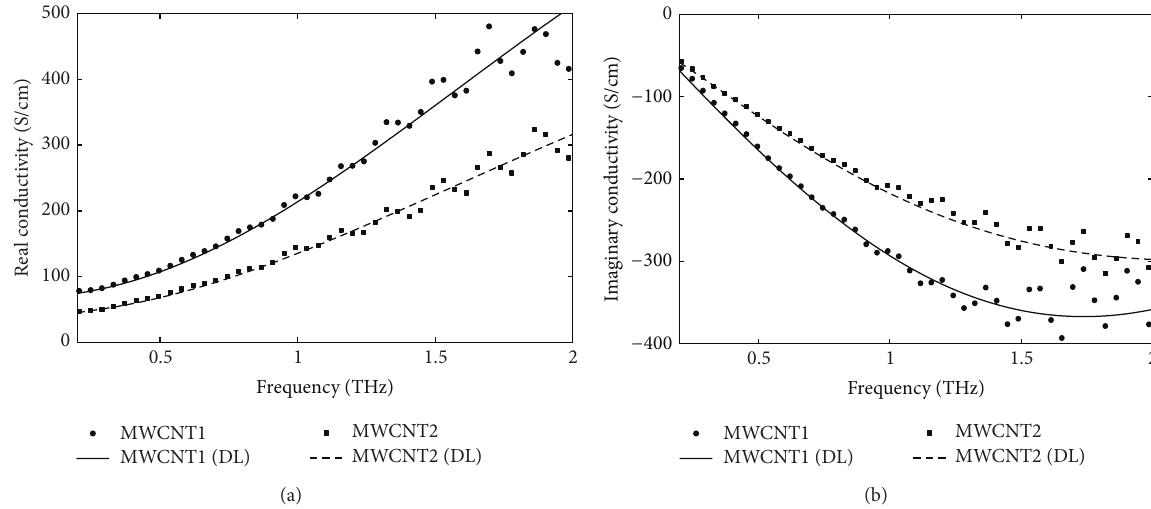
Figure 3: (a) Real and (b) imaginary parts of measured (markers) and fitted DL model (lines) results of electrical conductivity for MWCNT samples.